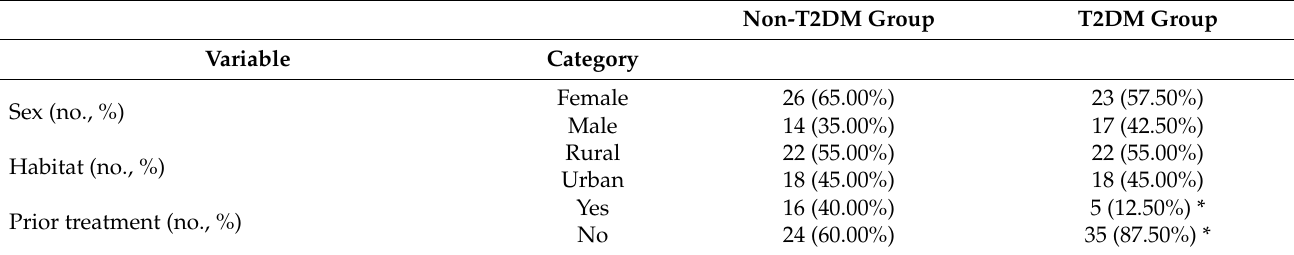
Table 1. General characteristics of the patients included in the